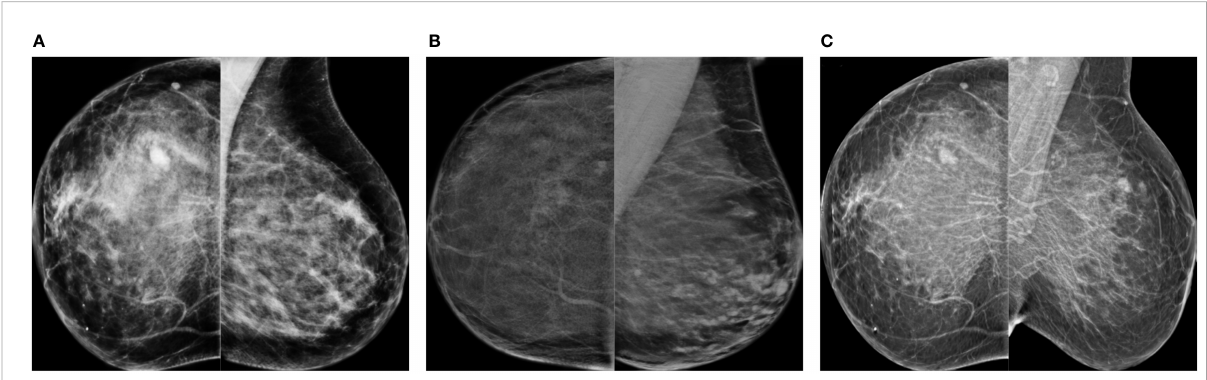
FIGURE 9 Synthetic high-density mammograms that looked realistic to the radiologist. Samples from the different CycleGAN models: (A) OP-CC and OP- MLO , (B) CS-CC and CS-MLO , (C) BC-All